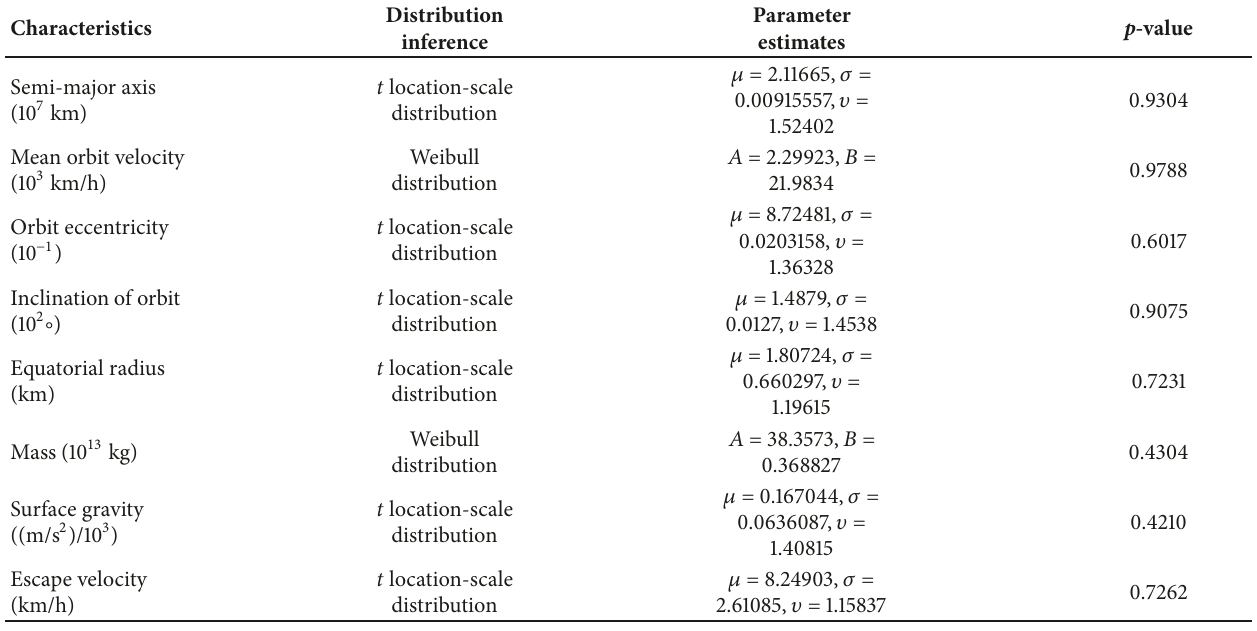
Table 3: The distribution inference in each orbital or physical characteristic (Ananke